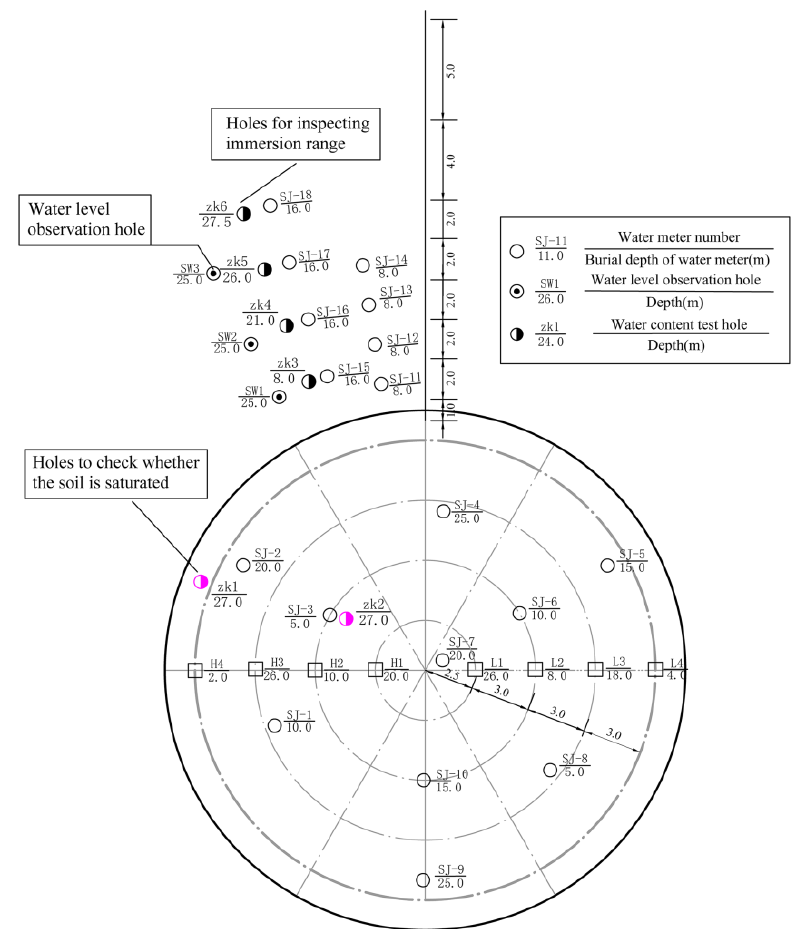
Figure 5. Plane diagrams of water content testing holes.